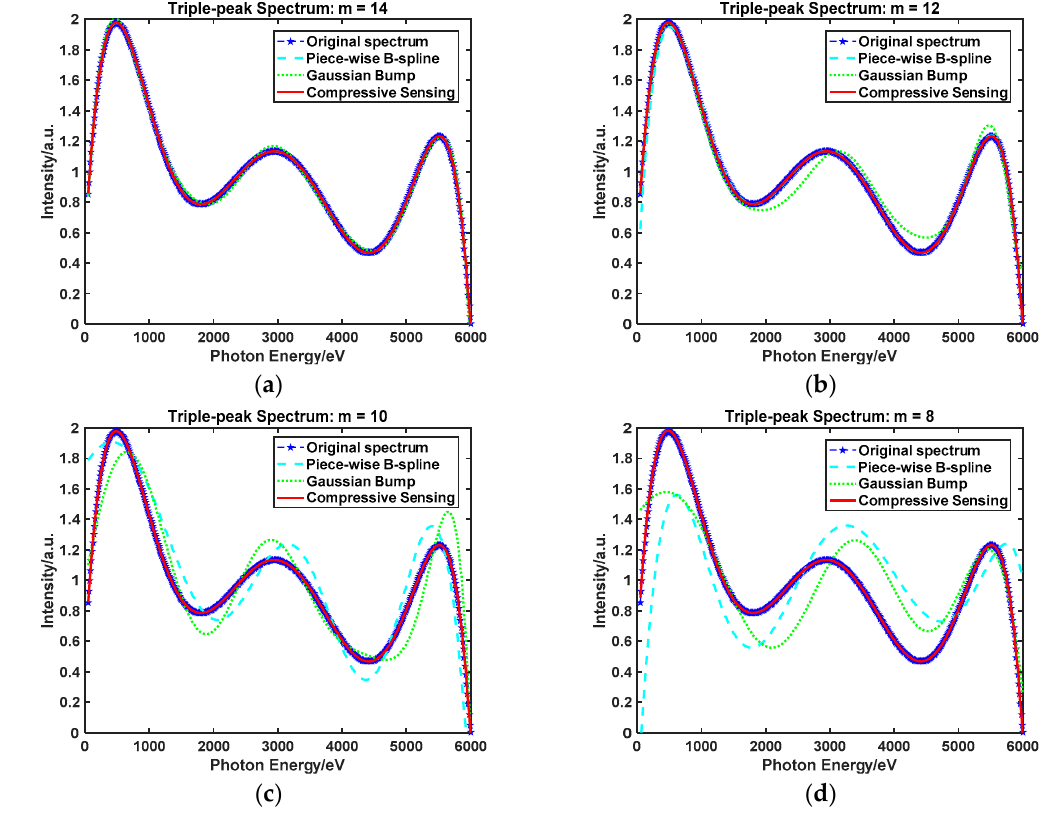
Figure 7. The Triple-peak spectrum recovery performance with three different spectrum unfolding methods as the measurements decrease. ( a ) The number of detection channels is 14. ( b ) The number of detection channels is 12. ( c ) The number of detection channels is 10. ( d ) The number of detection channels is 8.